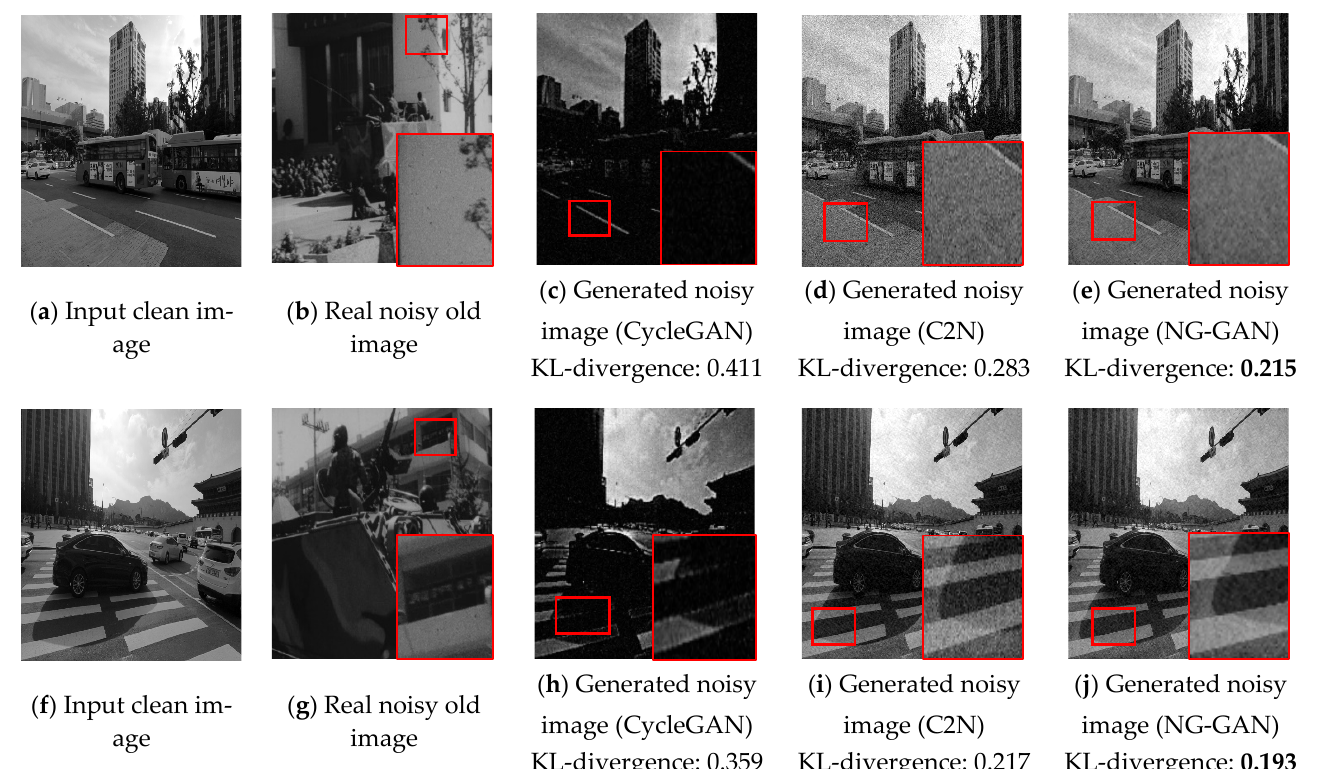
Figure 10. Visual comparison of noisy images generated by CycleGAN, C2N, and NG-GAN. ( a ) and ( f ) are high-quality images from the REDS dataset, ( b , g ) are noisy images generated by CycleGAN, ( c , h ) are noisy images generated by C2N, ( d , i ) are noisy images generated by the NG-GAN, and ( e , j ) are real noisy images from old videos.